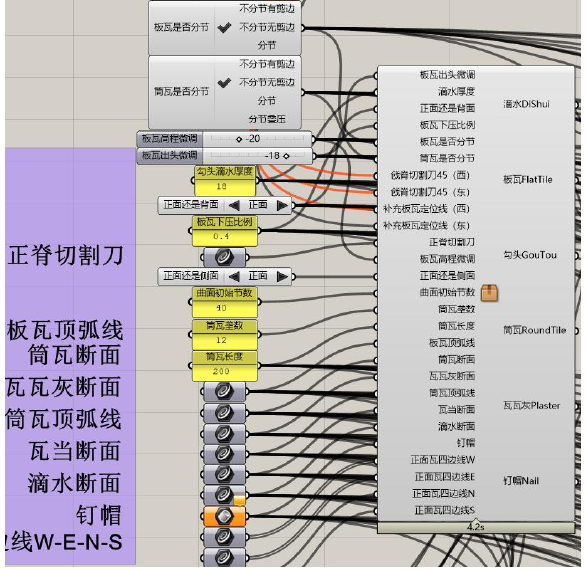
Figure 14. The binary cluster (generators) of roof tiles After 4.2 seconds, the tiles on the wing corner of the front slope are automatically generated. Similarly, ridges can be generated Figure 12. Details of Stone Balustrades automatically. According to the delivery requirements, different geometric details can be selected, such as modifying the “segmented or not segmented“ parameter, each tile or ridge with real size can be obtained, e.g. Figure 15, Figure